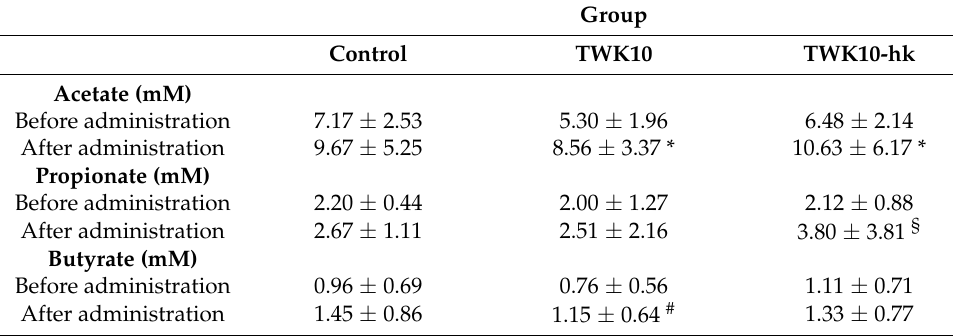
Table 3. Effects of TWK10 on SCFAs in